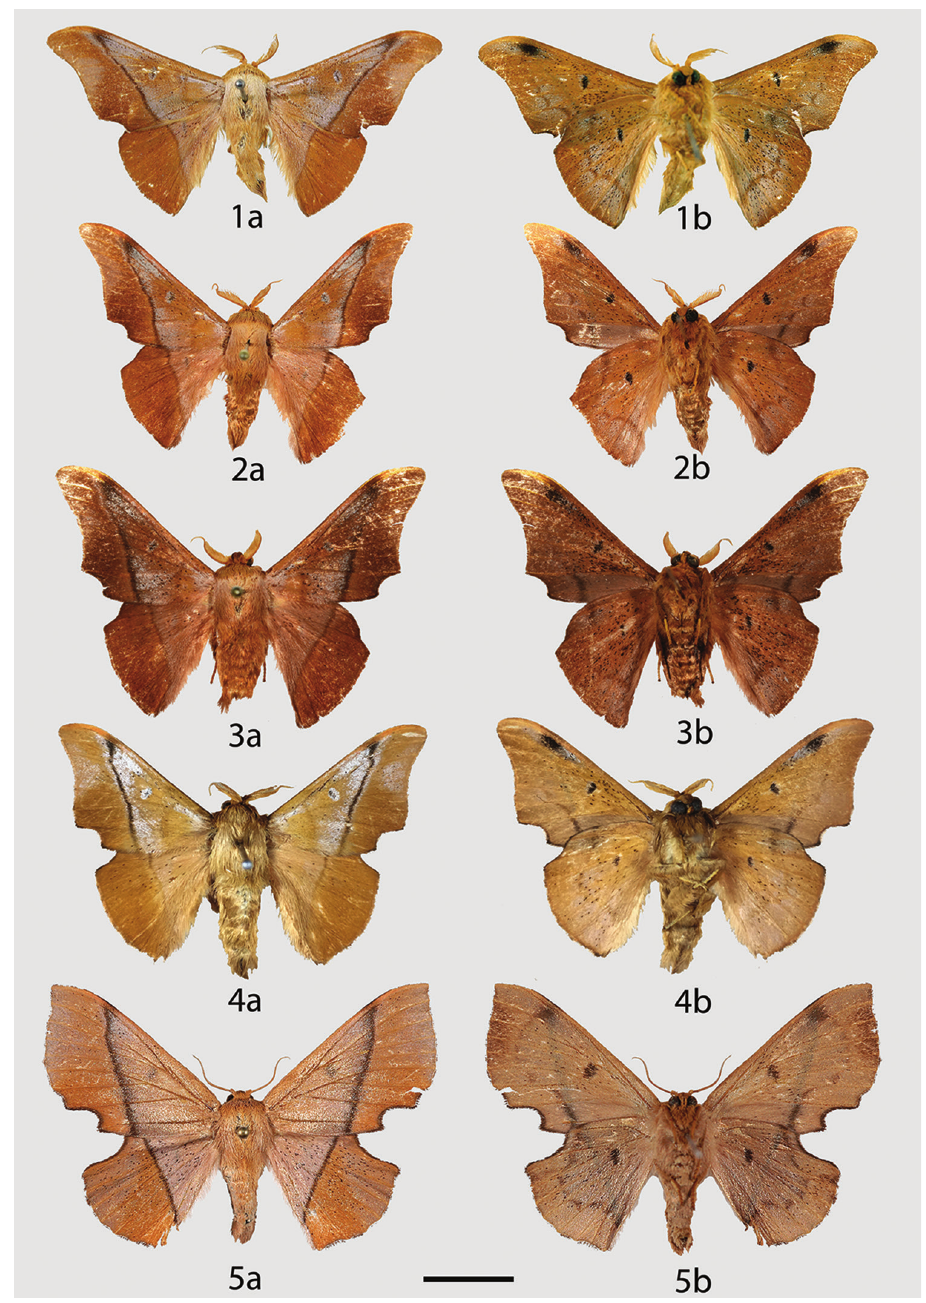
Figures 1–5. Reinmara enthona adults, a dorsal b ventral. 1 Holotype ♂ , French Guiana, St. Jean du Maroni (USNM) 2 ♂ , French Guiana, Kaw Rd., Camp Patawa (CDH) 3 ♂ , French Guiana, Patagai Rd., 58 m (CDH) 4 ♂ , Brazil, Rondônia, Porto Velho, 180 m (USNM) 5 ♀ , French Guiana, Kaw Rd., PK 37.5 + 2, 200 m (CDH). Scale bar: 1